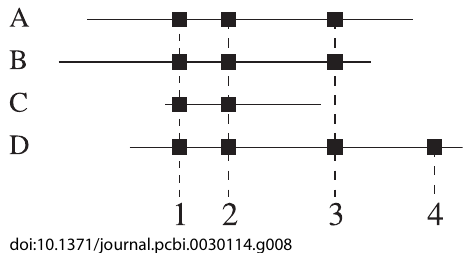
Figure 8. Issues in Protein Identification Complications in identifying proteins. Four proteins (A, B, C, D) are identified by four distinct peptides (black squares). Although A and B are different, it is impossible to ascertain which molecule is present, as both have been identified by the same (shared) peptides. A variation of this is shown in C. Protein D shares three peptides with A and B, and two with C, but also has a specific fourth peptide. From this information it can be concluded that D is in the